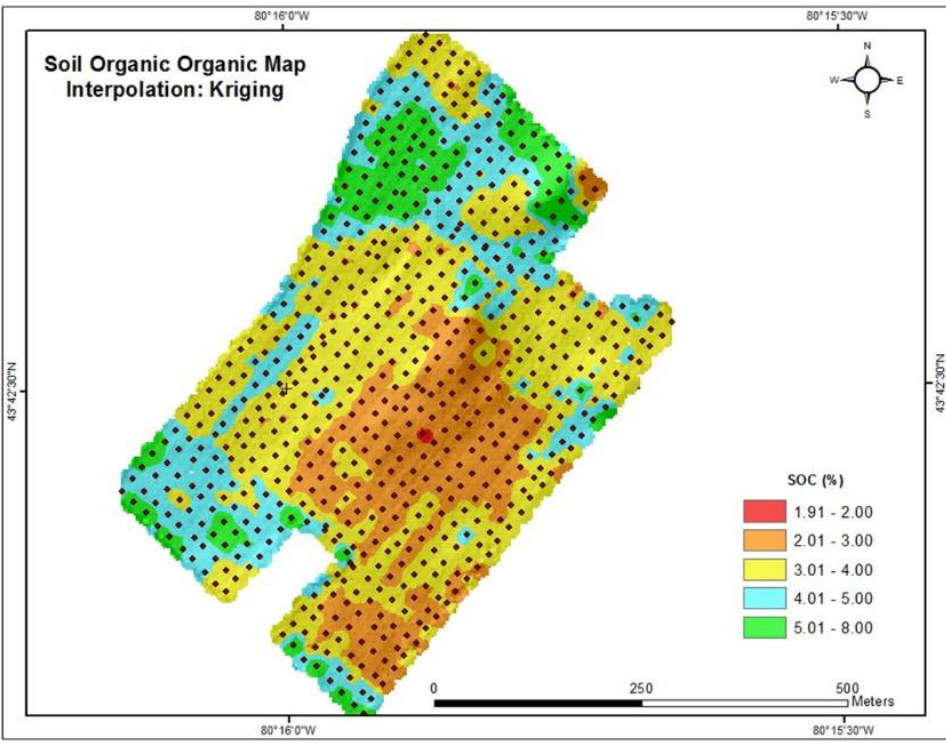
Figure 2. Map of the investigated site showing the spatial variability of SOC levels. The map was generated at 20-m resolution using a kriging interpolation. generated at 20-m resolution using a kriging